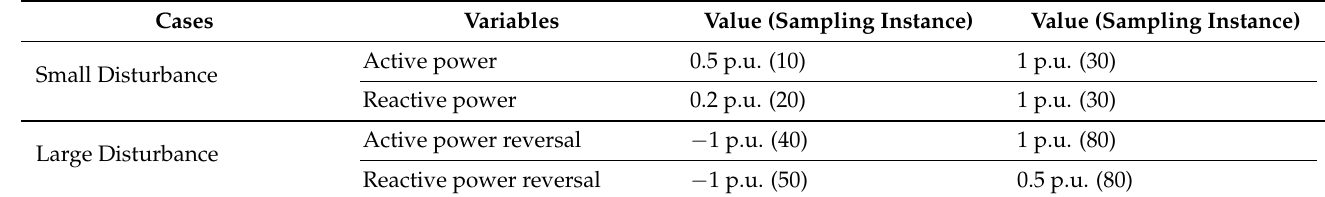
Table 7. Cases for the indirect implicit MPC simulation